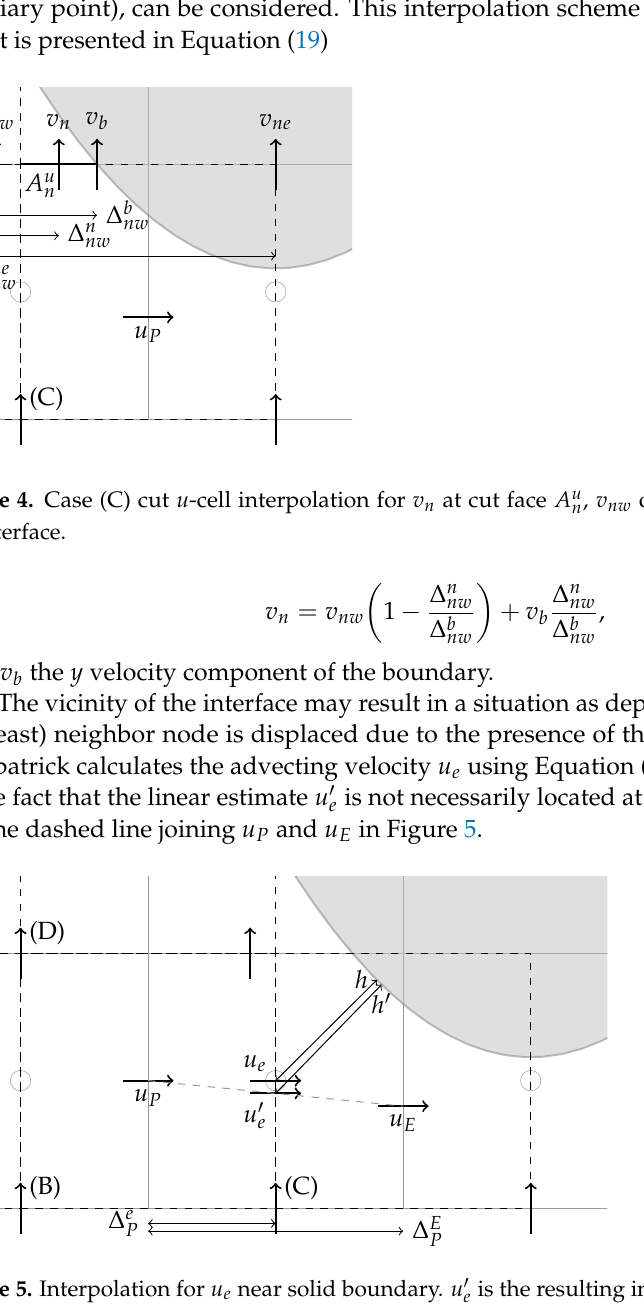
Figure 5. Interpolation for u e near solid boundary. u (cid:48) e is the resulting interpolation between u P and u E , which is corrected to the face center with the distances to the solid boundary h and h (cid:48)